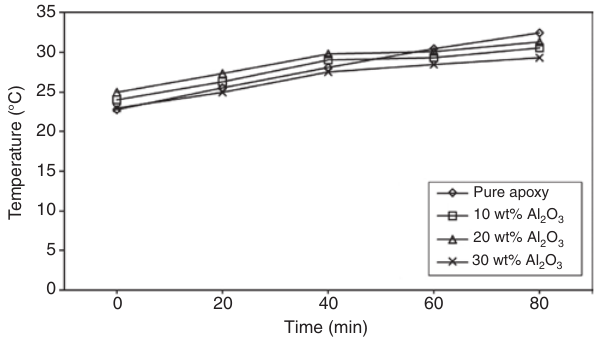
O -filled epoxy compos- 2 3